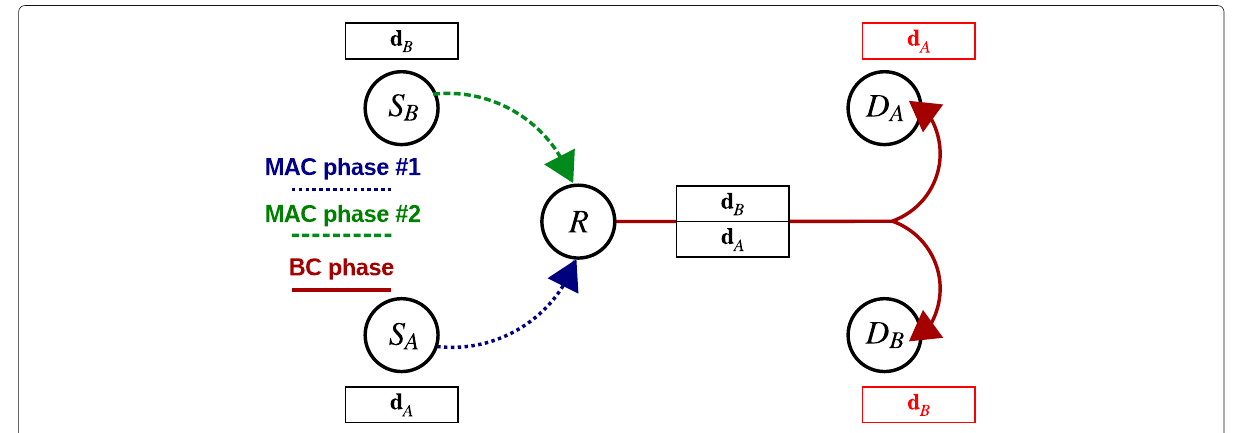
Fig. 20 for the corresponding result. As one can see, the proposed framework significantly outperforms both reference three-step scenarios as well the corresponding theoretical limits even if the pre-rotation is off! The bottleneck for the three-step routing is the BC channel because it needs to pass